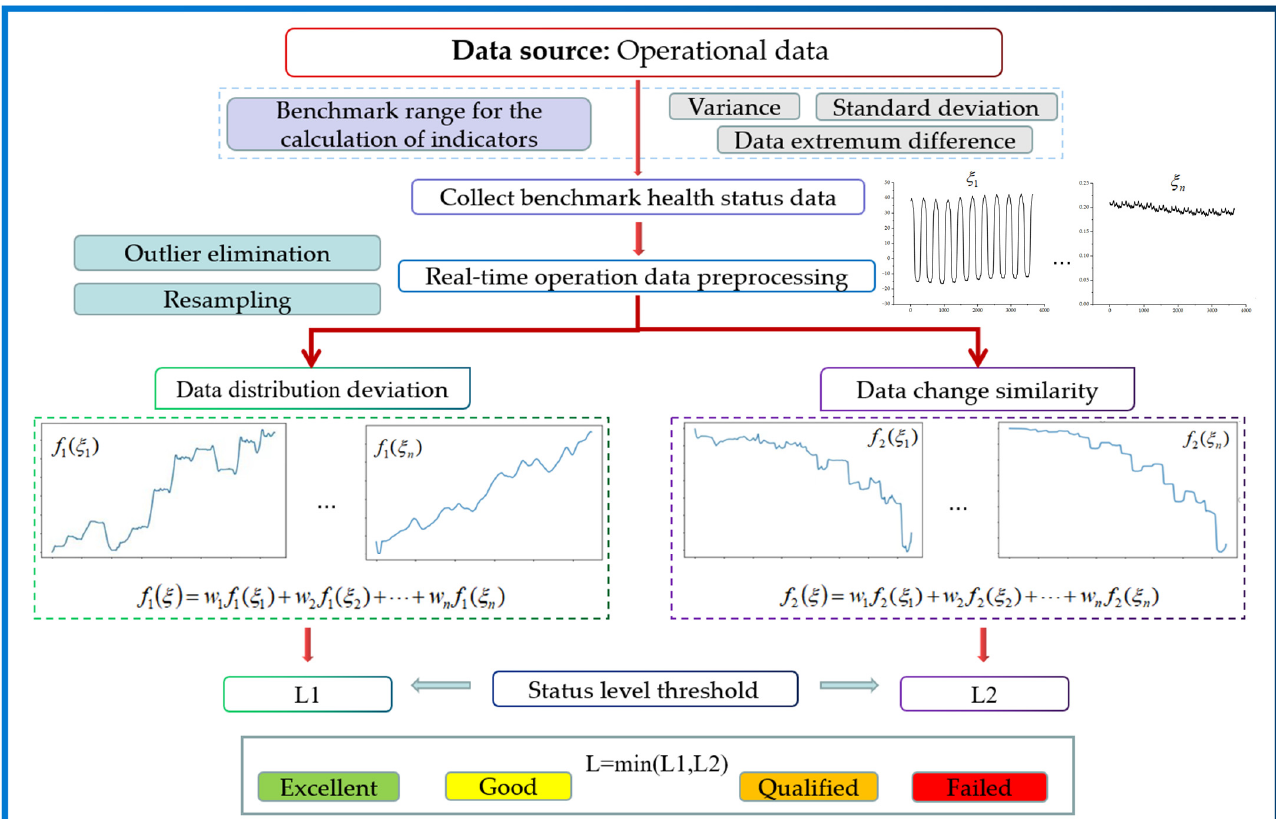
Figure 1. Online health assessment process for satellite components based on multiparametric data distribution characteristics.